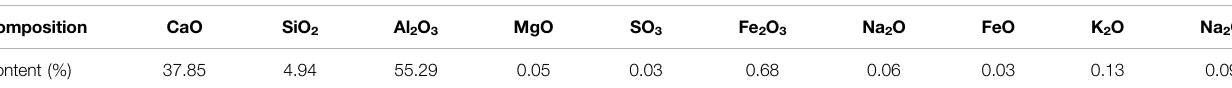
TABLE 2 | Chemical composition of CAC.